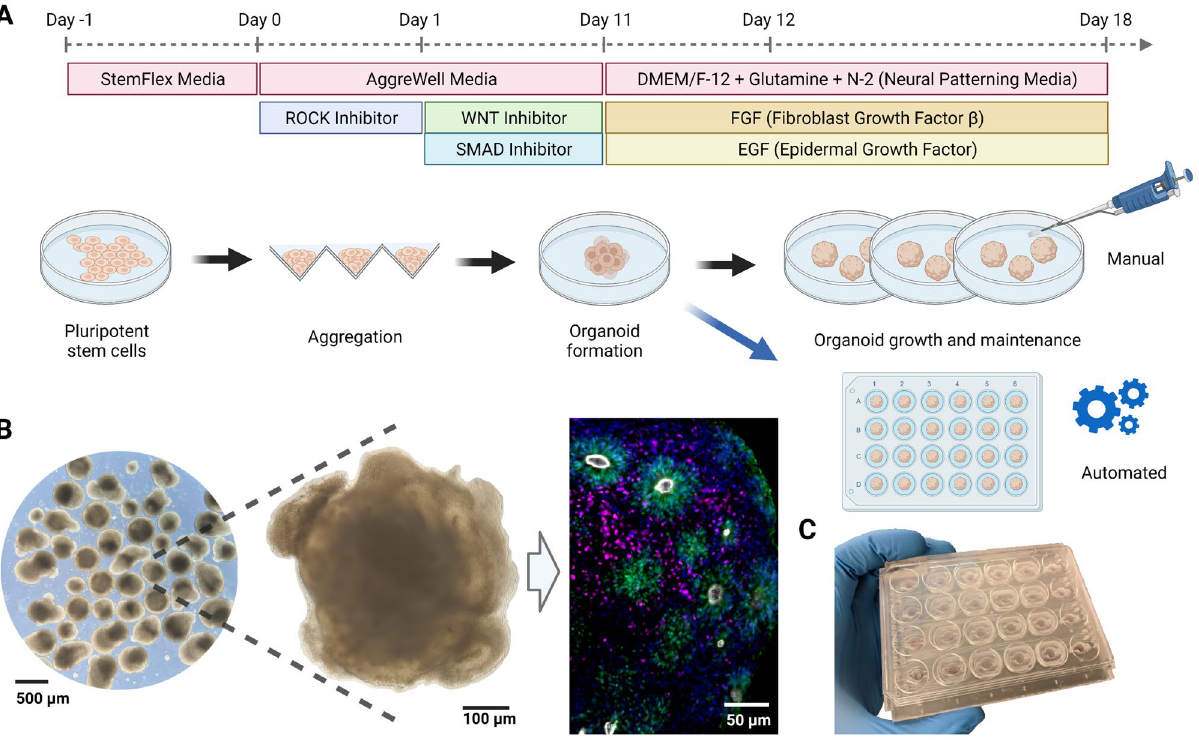
Figure 1. Overview of the human cerebral organoid generation protocol. ( A ) Human pluripotent stem cells are expanded in traditional 2D culture, dissociated, aggregated into microwells, and matured into 3D organoid cultures using defined media conditions to promote cerebral cortex tissue differentiation. In this study, on day 12 post-aggregation, organoids were either kept in suspension and maintained manually (black arrow) or transferred to individual wells of a microfluidic chip and maintained in automation (blue arrow). ( B ) Images of cerebral organoid cultures. Bright-field images at low (left) and high (center) magnification under standard culture conditions show organoid morphology and heterogeneity. Immunofluorescence stains on week 5 for PAX6 (green, radial glia progenitor cells), CTIP2 (BCL11B) (magenta, excitatory projection neurons), ZO-1 (TJP1) (white, tight junction proteins on radial glia endfeet, apical surface of the neural tube), show characteristic ventricular zone-like rosette structures with radial glia surrounded by neurons. Nuclei stained with DAPI (blue). ( C ) Image of the PDMS microfluidic chip. The custom cell culture chip, modeled after a standard 24-well plate, houses organoids for automated